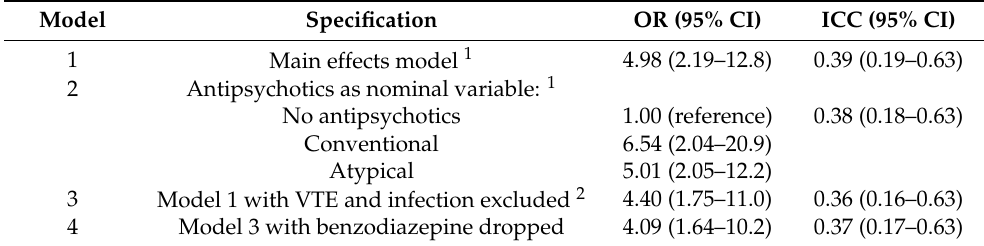
Table 5. Models of a cluster-specific random effects multivariable logistic regression of severe tachycardia on antipsychotic medication adjusted for